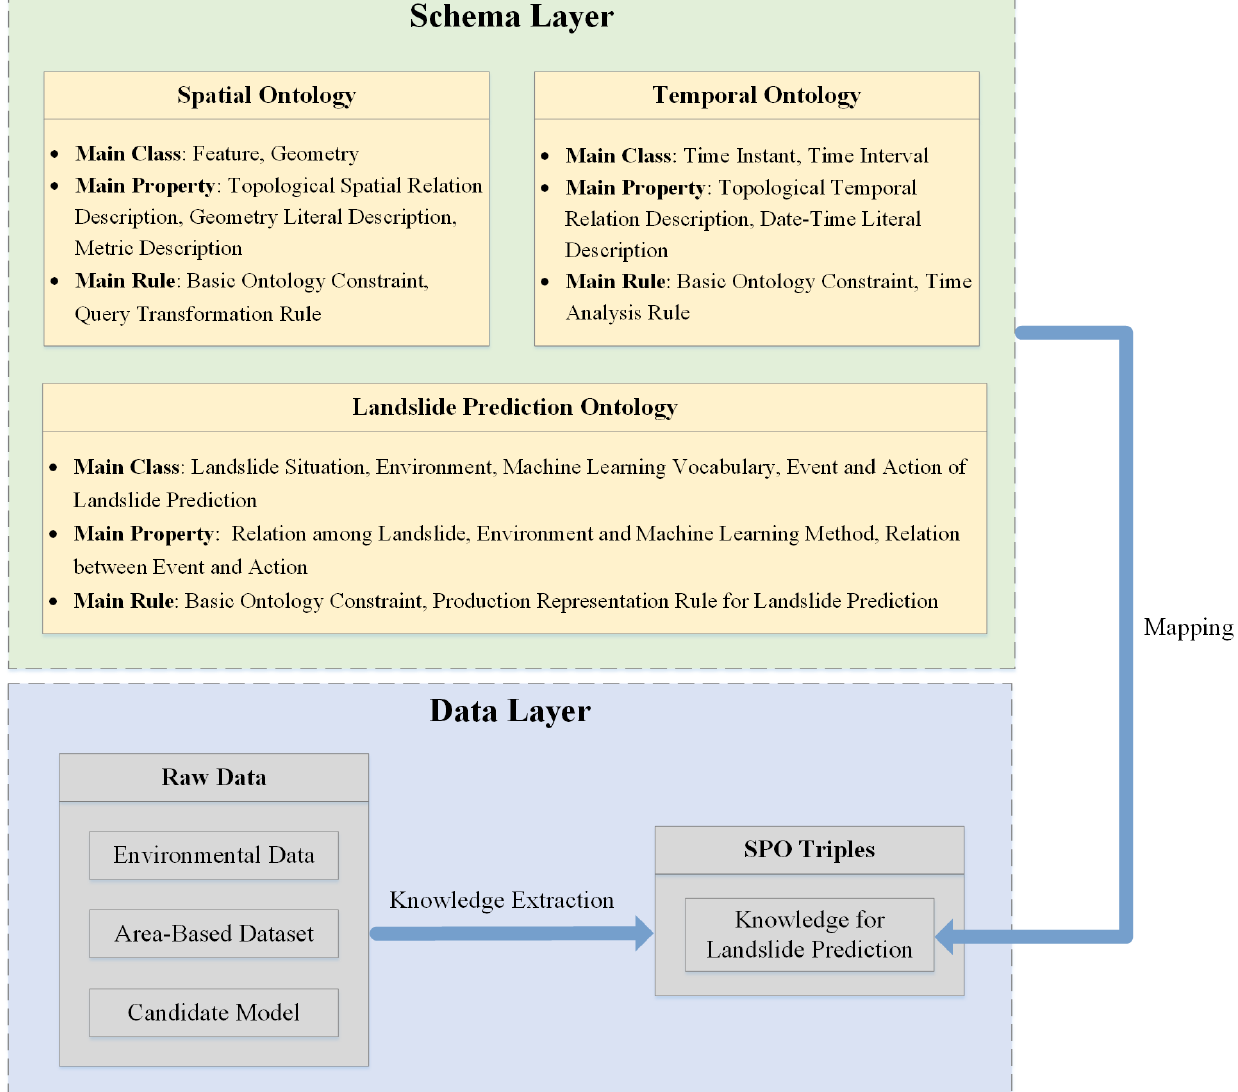
Figure 2. The structure of the spatio-temporal knowledge graph for Landslide